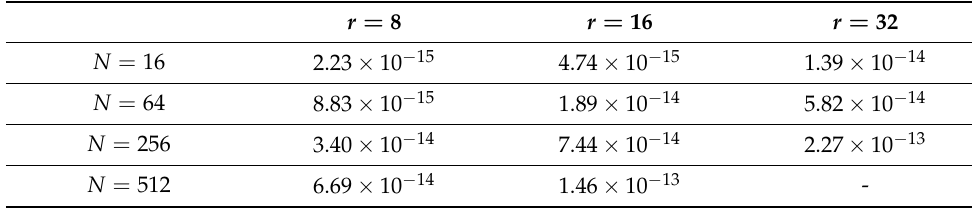
Table 2. Backward errors of the computed banded matrix by Algorithm